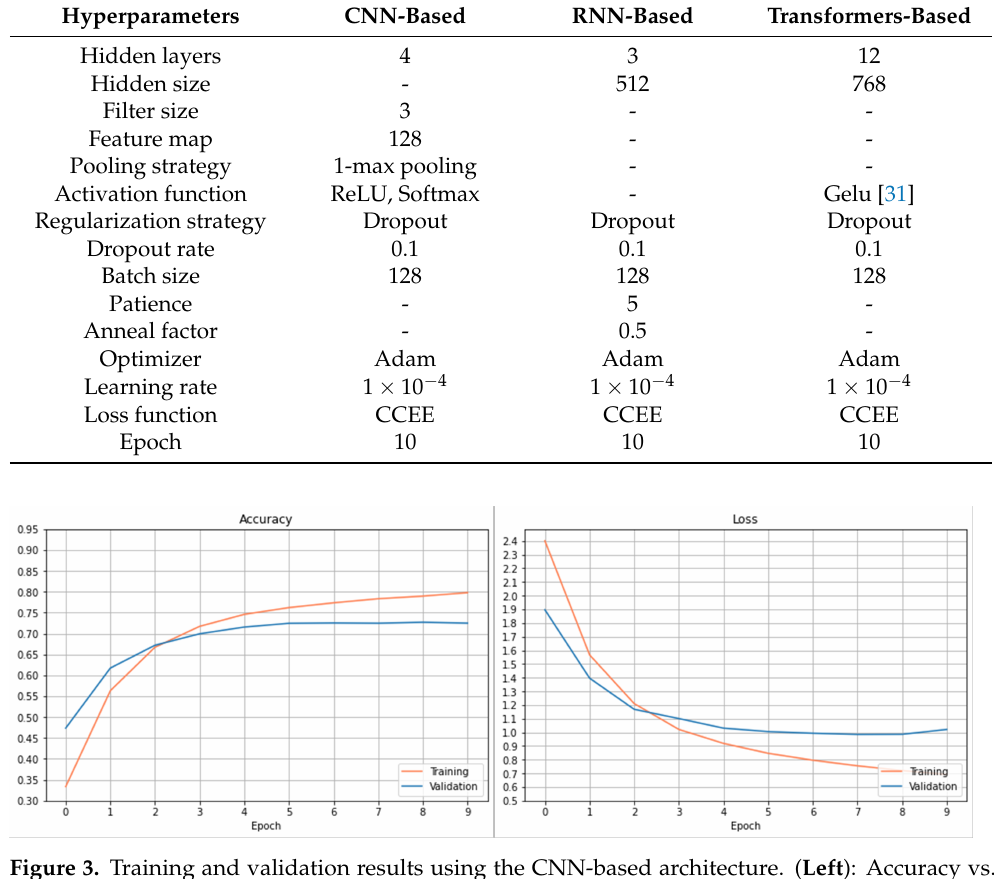
Figure 3. Training and validation results using the CNN-based architecture. ( Left ): Accuracy vs. epochs; ( Right ): Loss vs.